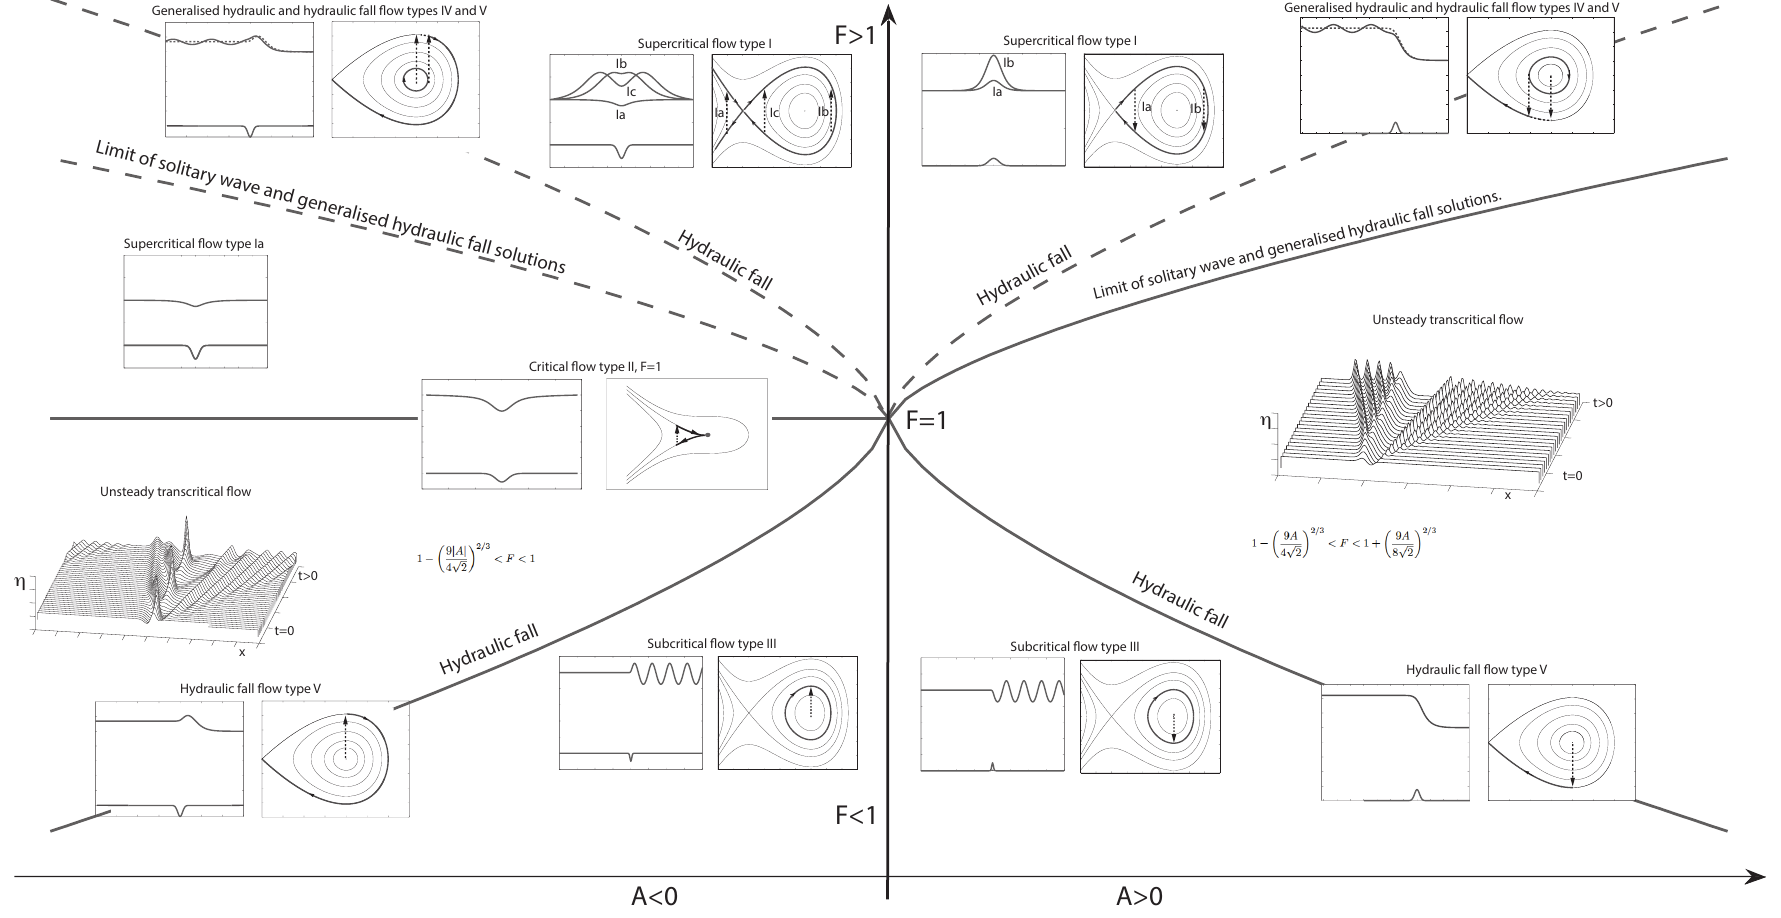
Figure 6. Steady solution space for flow over a small bump (or compact distribution of pressure on the free-surface) for the Korteweg–de Vries equation η xx + 9 (cid:112) gH and amplitude of forcing A [27,34,49,56,61,62,71,76]. Left-panels: Physical plane ( x , η ) . Right-panels: 6 ( F − 1 ) η = − 3 σ ≈ − 3 A δ with Froude number F = U / Phase plane ( η , η x ) . Only the first five of the eleven basic flow types I–V are possible. Note that the direction of the flow has been reversed in the panels with F <